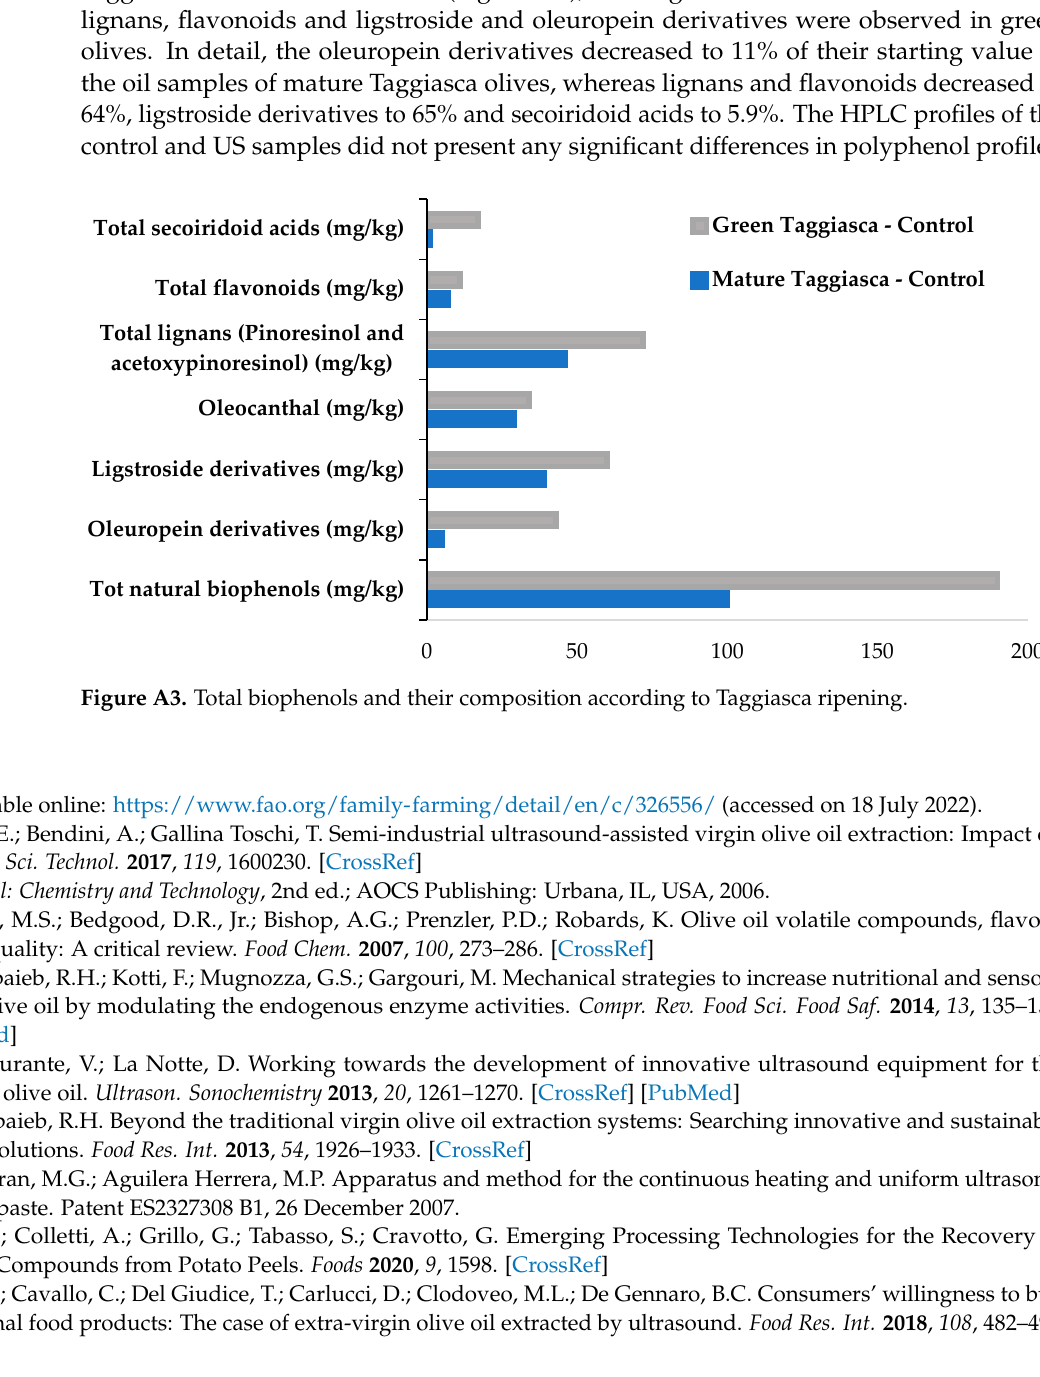
Figure A2. Total tocopherol and tocotrienol (almost α -tocopherol only) and polyphenol contents according to Taggiasca ripening and processing technology (mean ± SE bar).